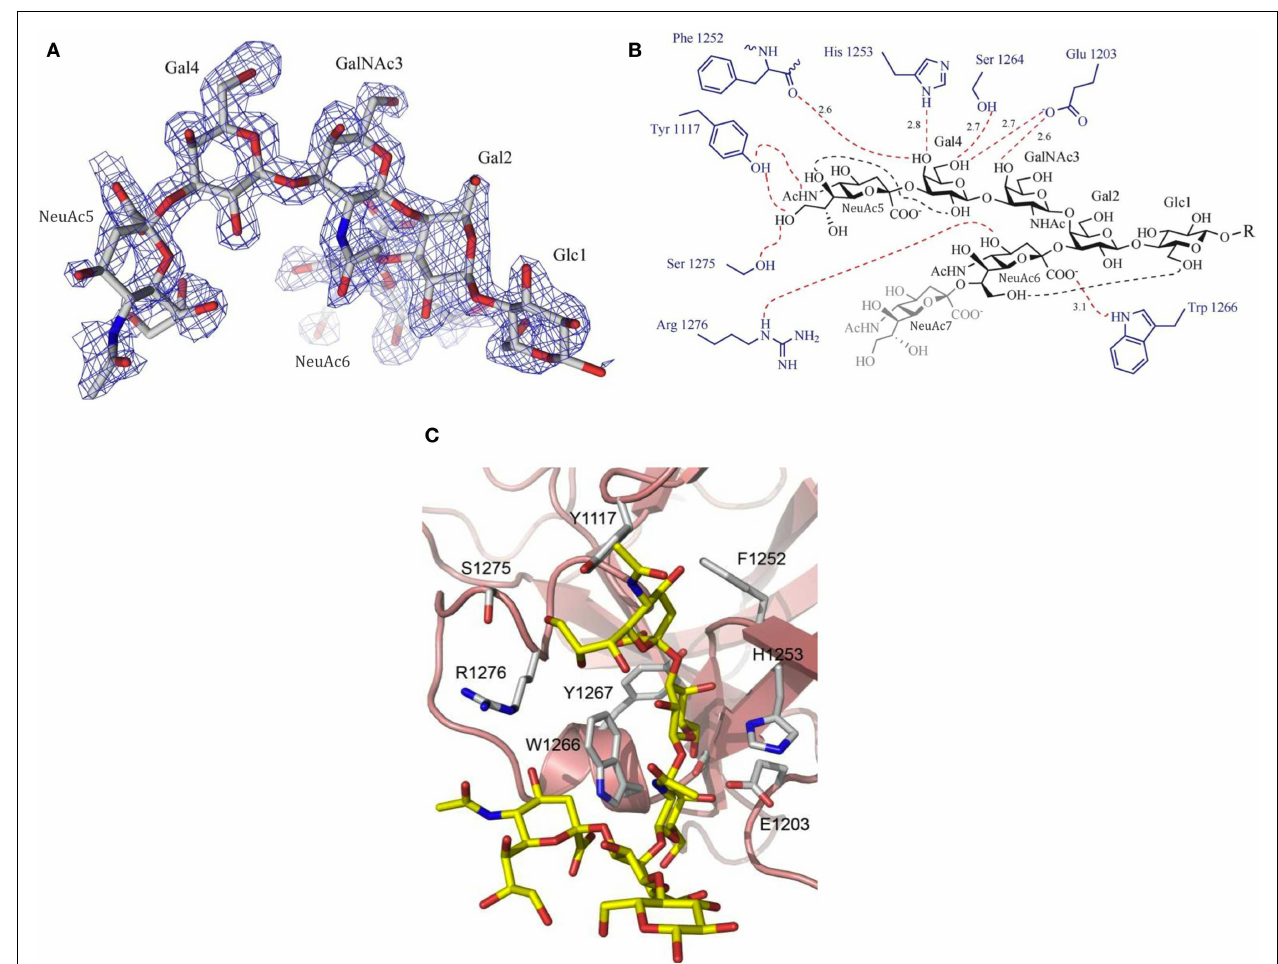
Hydrogen bonds are shown as dotted lines (red: intermolecular interactions; black: intramolecular carbohydrate–carbohydrate interactions). (C) Close-up view of the ligand-binding site. Please note the aromatic stacking interactions withTrp 1266 andTyr 1117. Printed with permission from Ref.